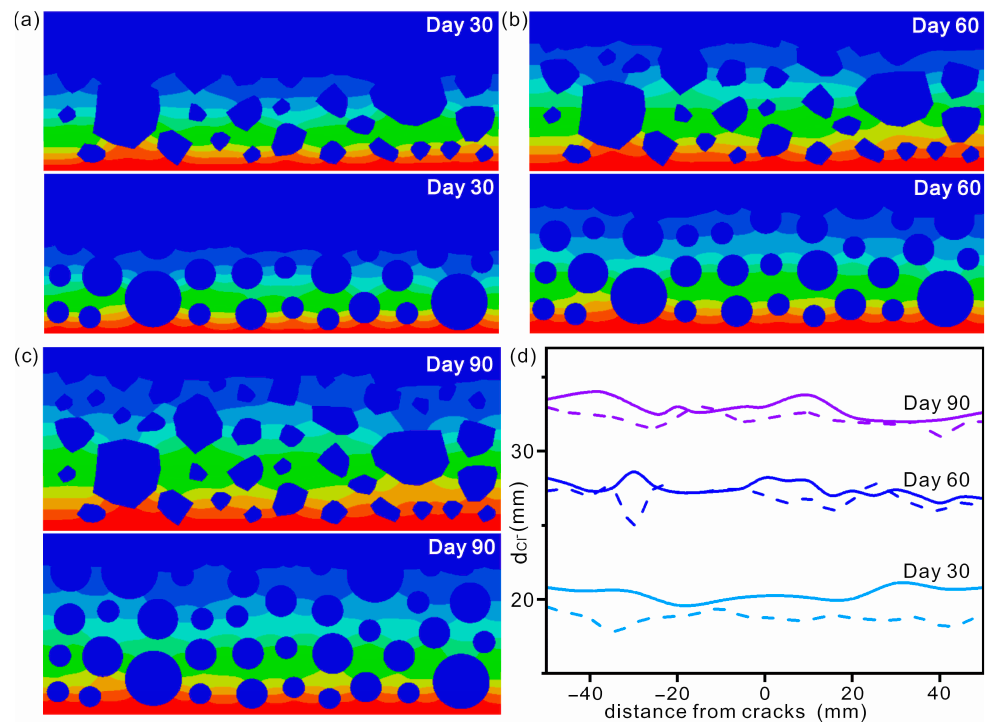
Figure 9. Di ff usion cloud maps of chloride ions in concrete with random polyhedral AGGs and circular AGGs for ( a ) 30 days, ( b ) 60 days and ( c ) 90 days. ( d ) Outermost di ff usion contours of chloride in concrete after immersion for di ff erent times. The solid and dashed lines represent the AGGs with random polygons and regular spheres, respectively.